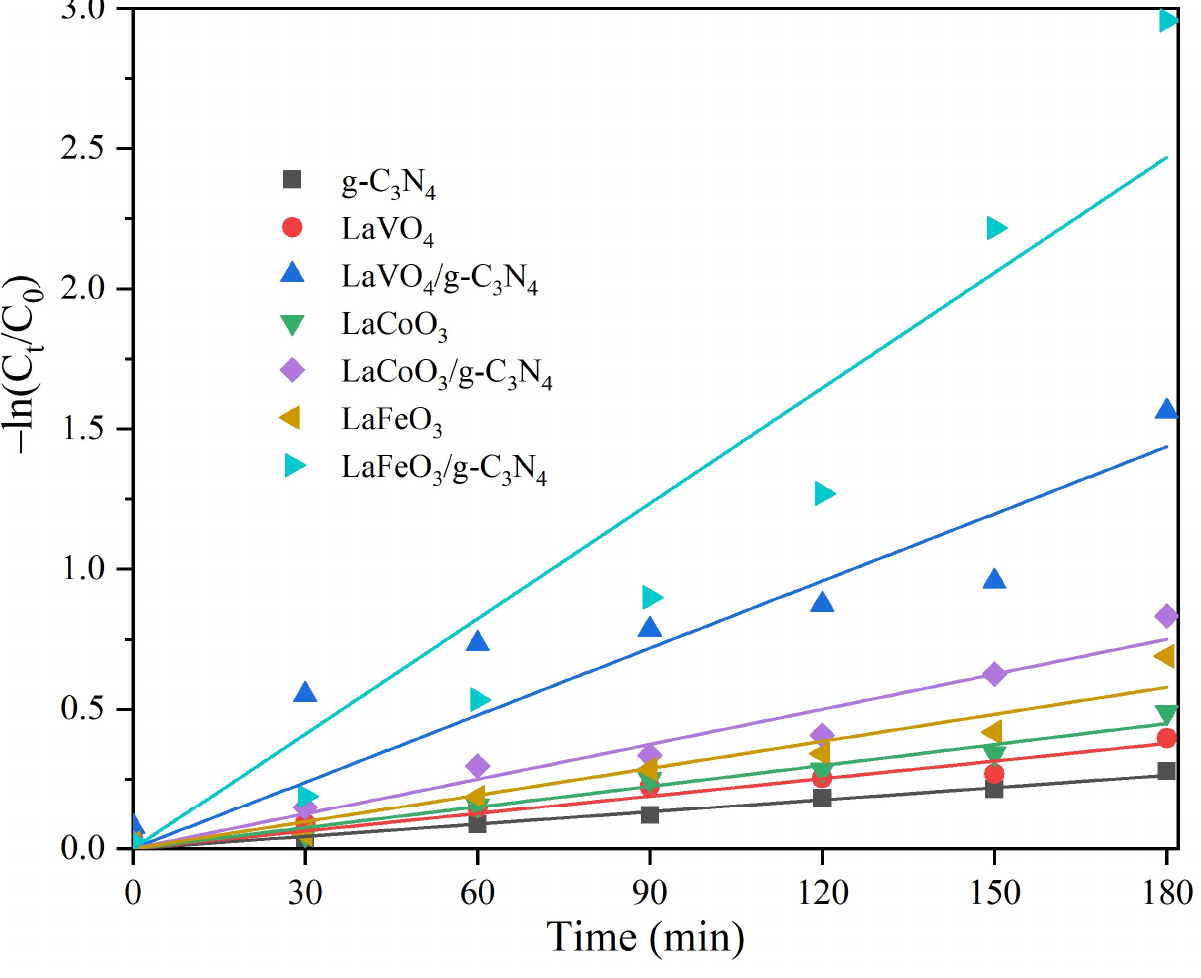
Figure 8. Kinetic curves of all samples. Table 1. Photocatalytic results of all